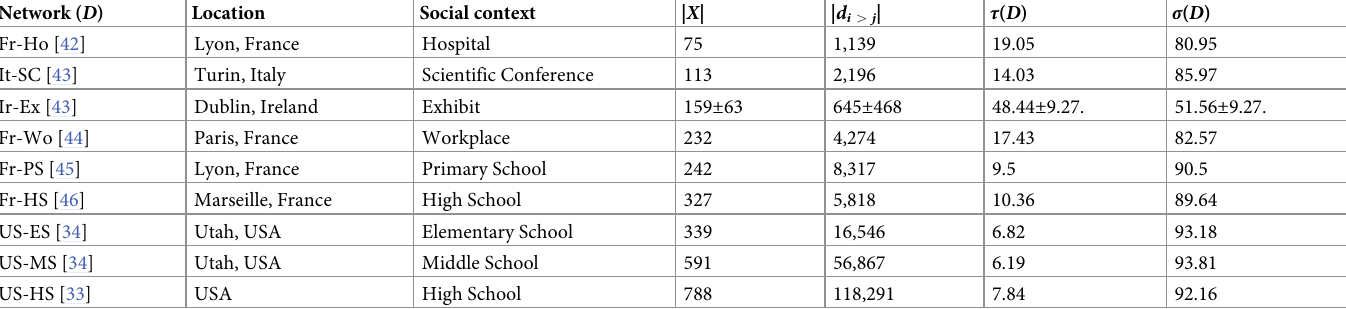
Table 1. Distance graphs ( D ) of the social contact networks analyzed, with respective references. | X |: number of nodes; (| d i > j |): number of finite distance edges; τ ( D ) relative size of the metric backbone; σ ( D ): edge redundancy. Values of τ , and σ are shown as percentages (%). For the Exhibit networks, values of | X |, (| d i > j |), τ and σ denote the mean ± standard deviation of the networks computed for each of the 69 days for which data were gathered. See Section 4.1 for additional details and a description of the networks. Network ( D